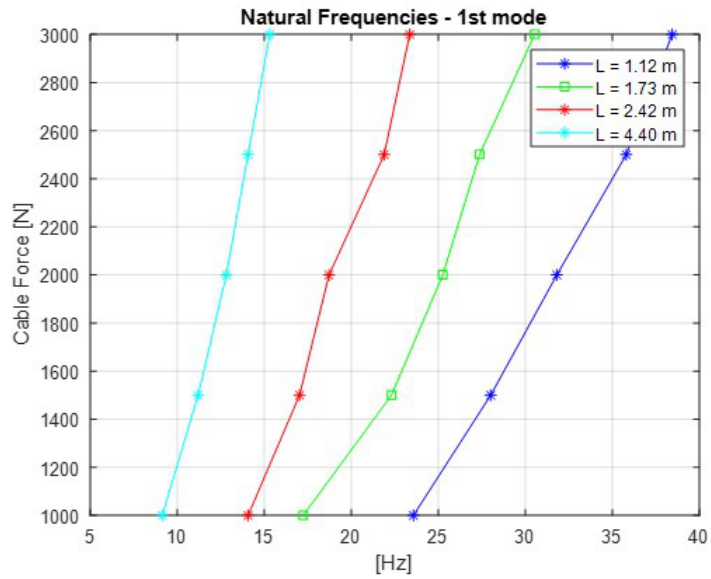
Figure 6. Relationship between the cable force and natural frequencies. Comparing the measurements of the natural frequencies of the cable during the loading or unloading cycles, it is possible to observe that there is no significant variation in their